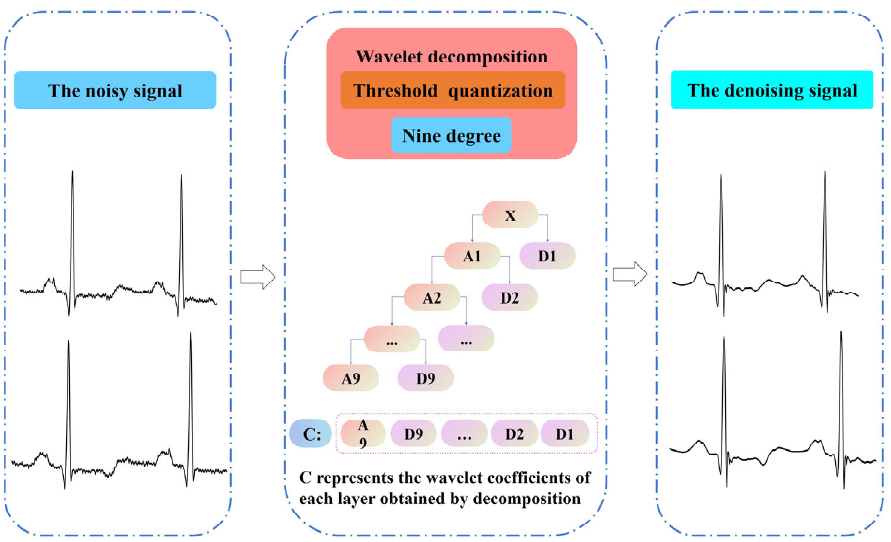
Figure 5. Comparison diagram before and after wavelet denoising.